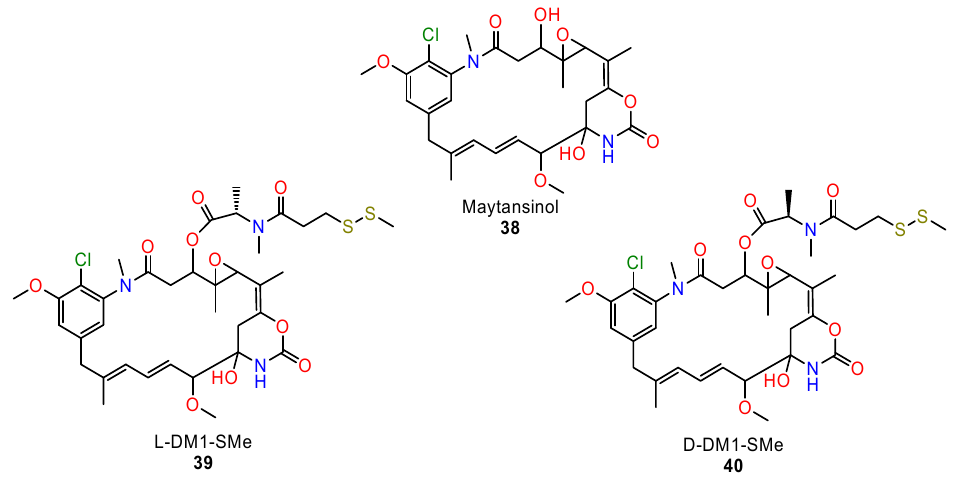
Figure 17. The structures of chiral derivatives of maytansine.